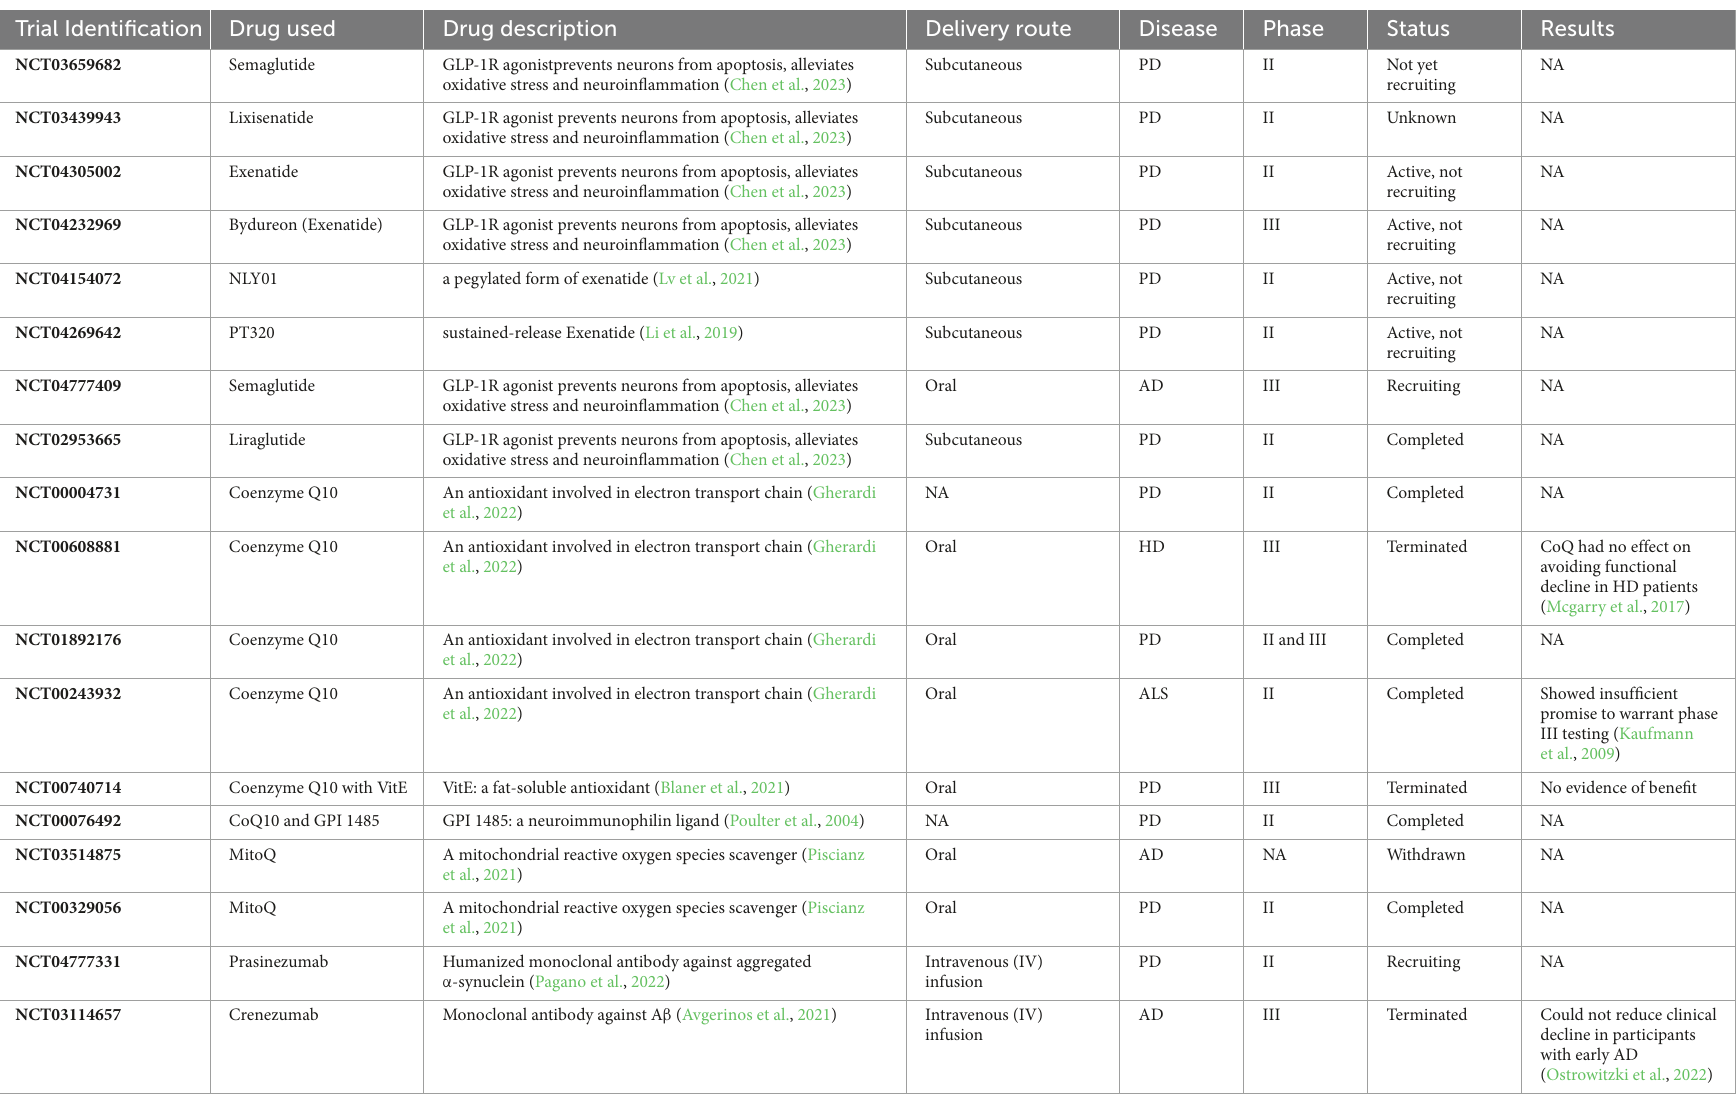
TABLE 1 Clinical trials associated with neurodegenerative diseases. Trial